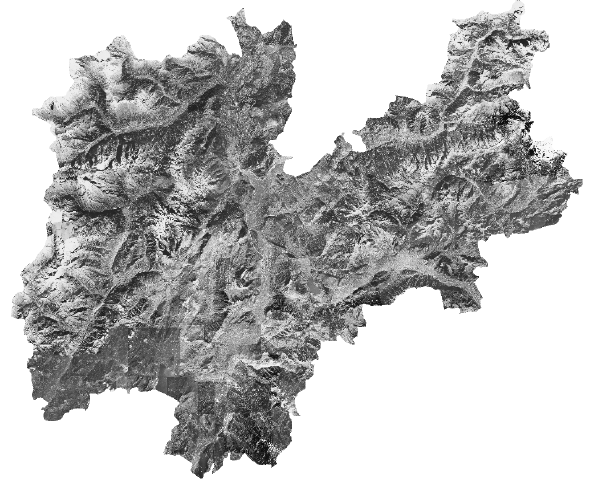
Figure 6. Mosaic of the 1954 ortho-photos.